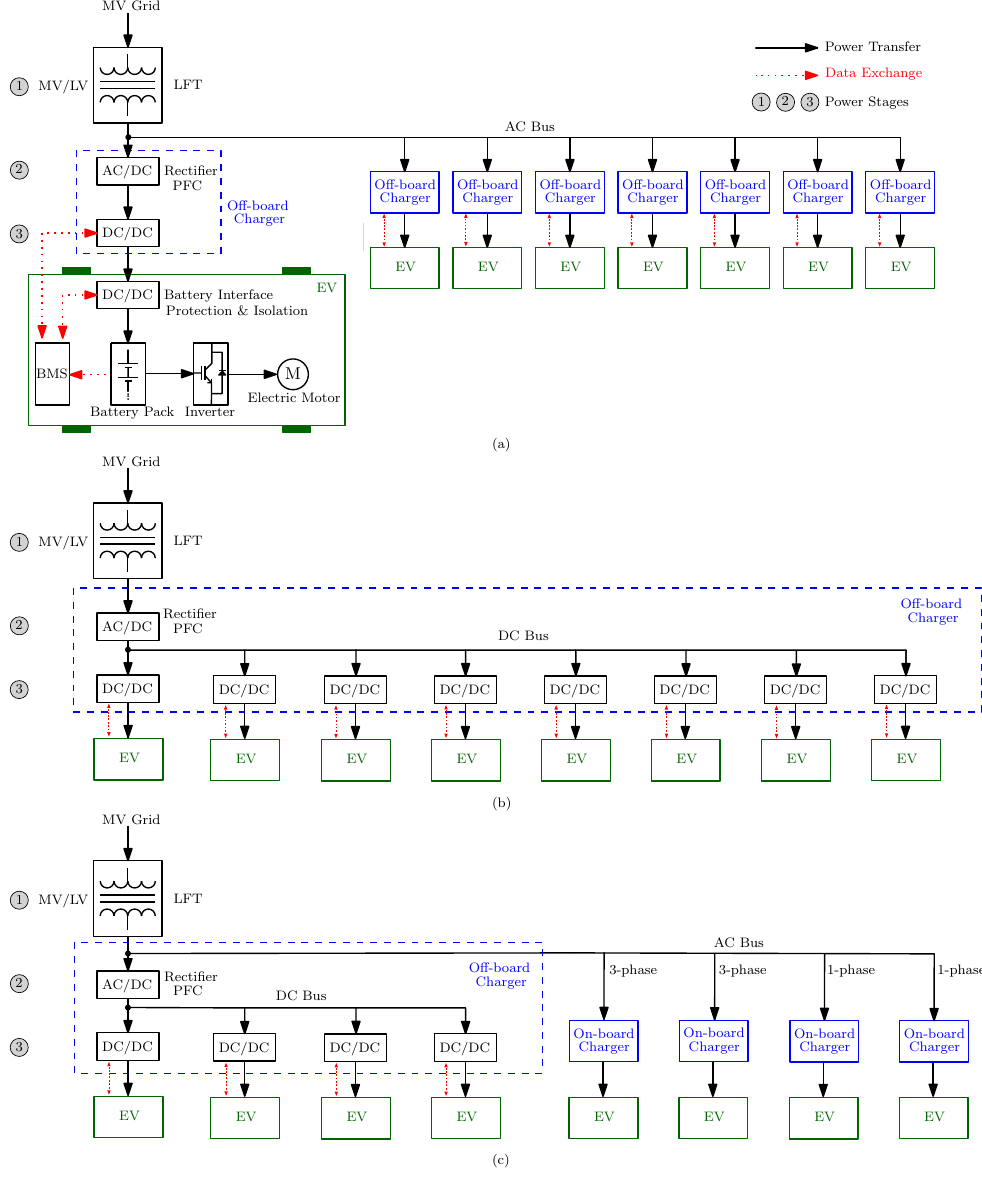
Figure 4. The LFT-based ultra-fast charging station configurations: ( a ) AC-coupled; ( b ) DC-coupled; ( c )